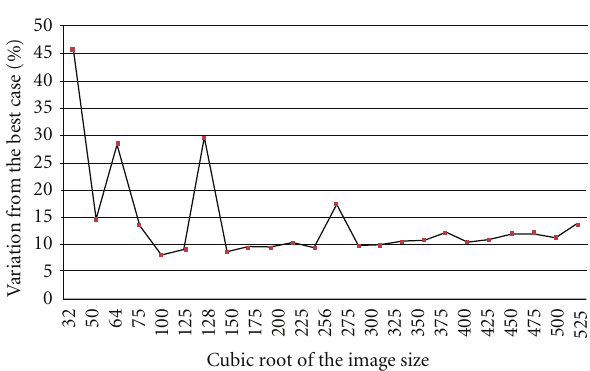
Figure 10: The variation of the runtime when ECC is enabled as a percentage of the best case for the C2070